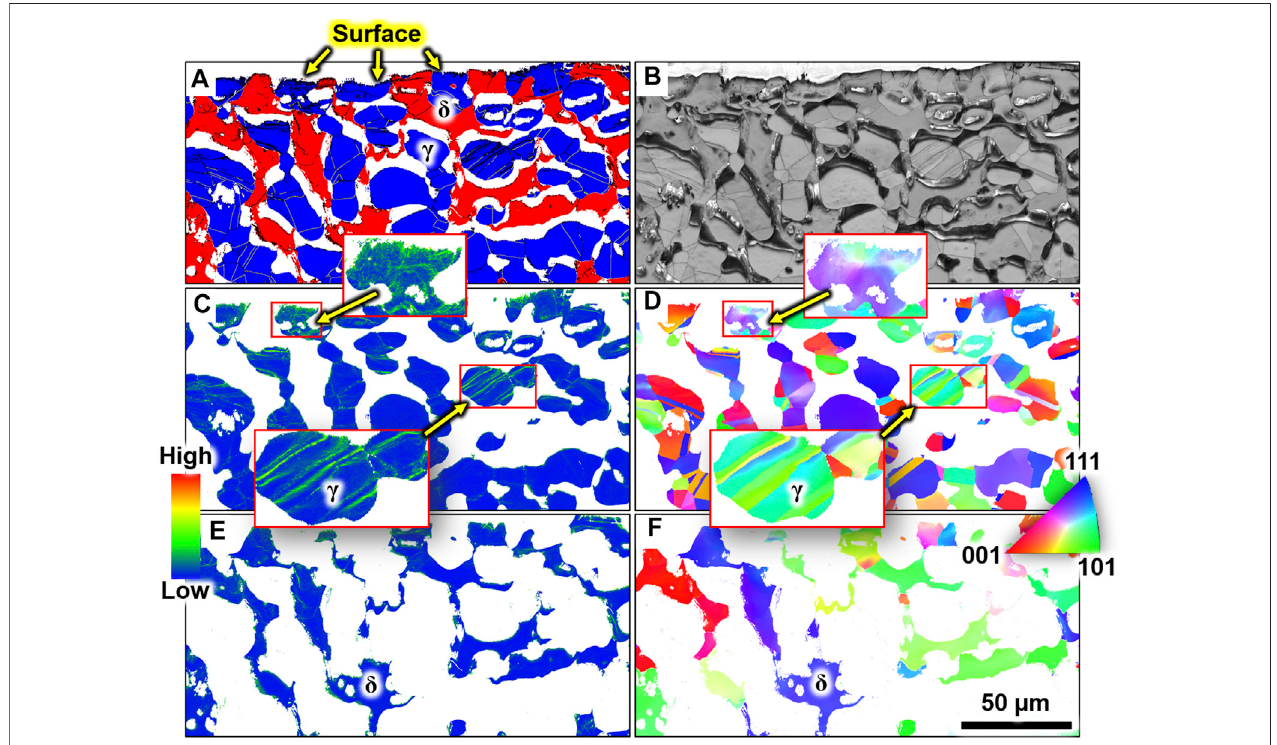
FIGURE9| Post-mortemEBSDmicrostructureanalysisafterexposuretocathodichydrogencharging,showingthemapsof (A) phase, (B) bandcontrast, (C) local misorientation of the austenite, (D) inverse pole fi gure in the normal direction of the austenite (perpendicular to the rolling direction and tensile loading axis), (E) local misorientation of the ferrite, and (F) the inverse pole fi gure in the normal direction of the ferrite. The ESBD map was acquired from the edge of the tensile specimen (i.e., the exposed surface to hydrogen uptake) that was cut along the transverse direction of the sample. Hydrogen infusion occurred from the top periphery of the mapsshowinghighstrainlocalization,particularlyfortheaustenite.Theaustenitegrainswerehighlydeformedupto80 µmbelowthesurface.Thescalebarin (F) applies to all maps. The tensile loading axis was along the horizontal axis. The white background in (A) shows non-indexed regions while black lines show low- and high-angle grain